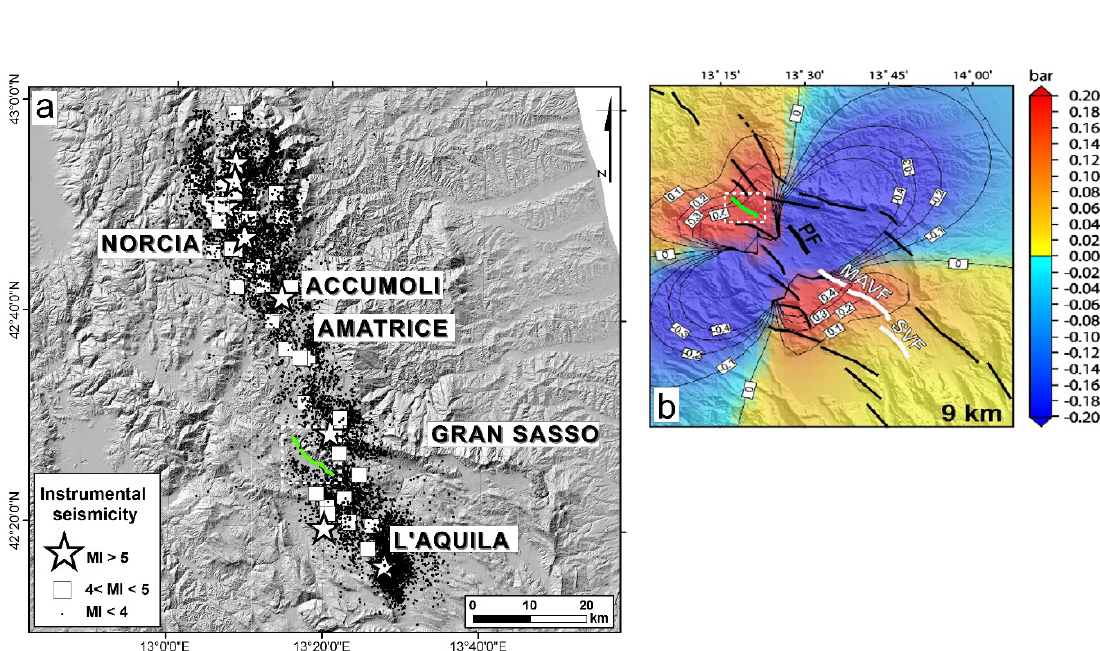
Fig. 4: a) Instrumental seismicity of the study area during the 2009 and 2016 seismic crisis. Green lines within the white dashes rectangle represents the Mt. Marine fault trace. b) Coseismic Δ CFF patterns, evaluated 9 km at depth. Each contour line evidences a CFF variation of 0.1 bar (Falcucci et al.,